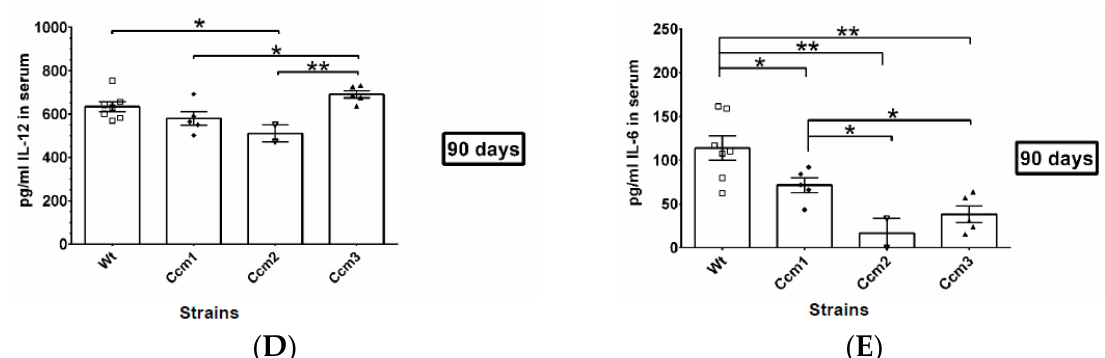
Figure 5. The disrupted BBB is not caused by local inflammatory reactions in Ccms mutant mice. ( A ) Monocytes, neutrophils, large peritoneal macrophages (LPM), and small peritoneal macrophages (SPM) within the peritoneal cell populations were collected through peritoneal lavage. Quantifica ‐ tion of percentage of ( I ) monocytes (CD45.2 + CD11b+ Ly6G ‐ Ly6Chigh), ( II ) neutrophils (CD45.2 + CD11b+ Ly6CintLy6Ghigh), ( III ) LPM (CD45.2 + CD11b+ Ly6G ‐ Ly6C ‐ F4/80hiMHC ‐ IIlo), and ( IV )